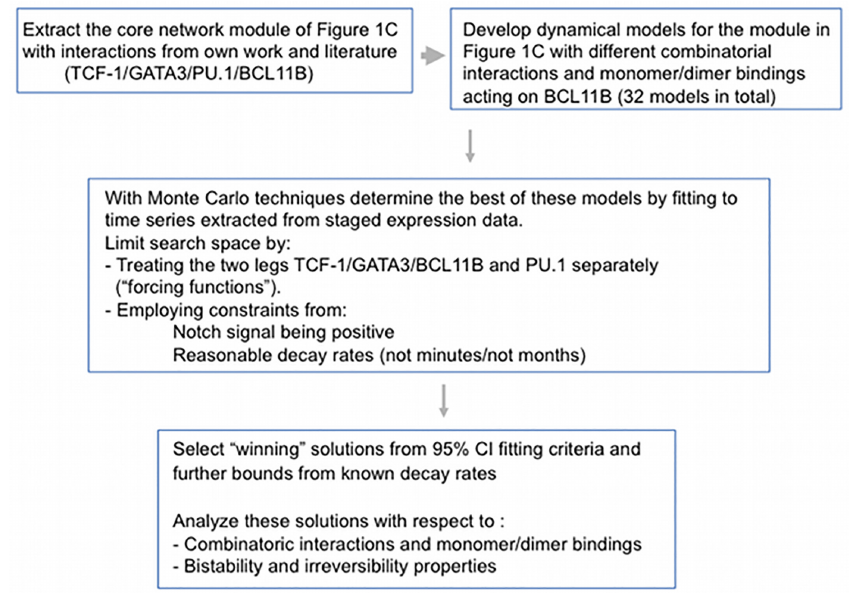
Fig 2. Workflow. Workflow from the selection of core module, extraction of gene expression of time series to fitting procedures and parameter estimation and selection for the TCF-1, GATA-3, and BCL11B dynamics.